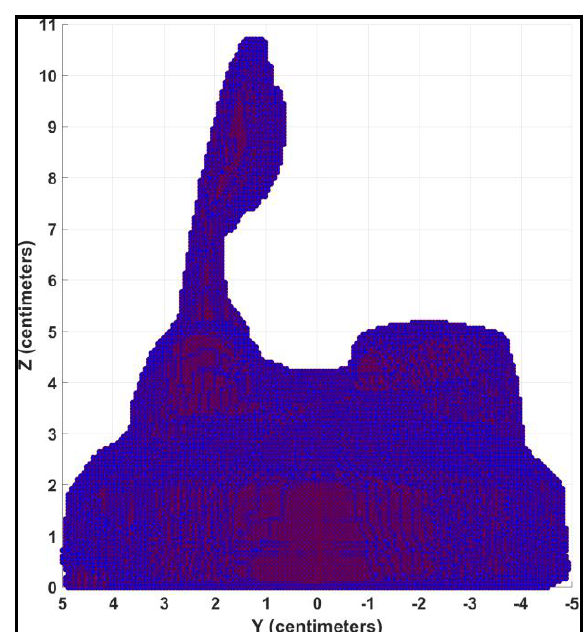
Figure 8. Reconstructed model (view